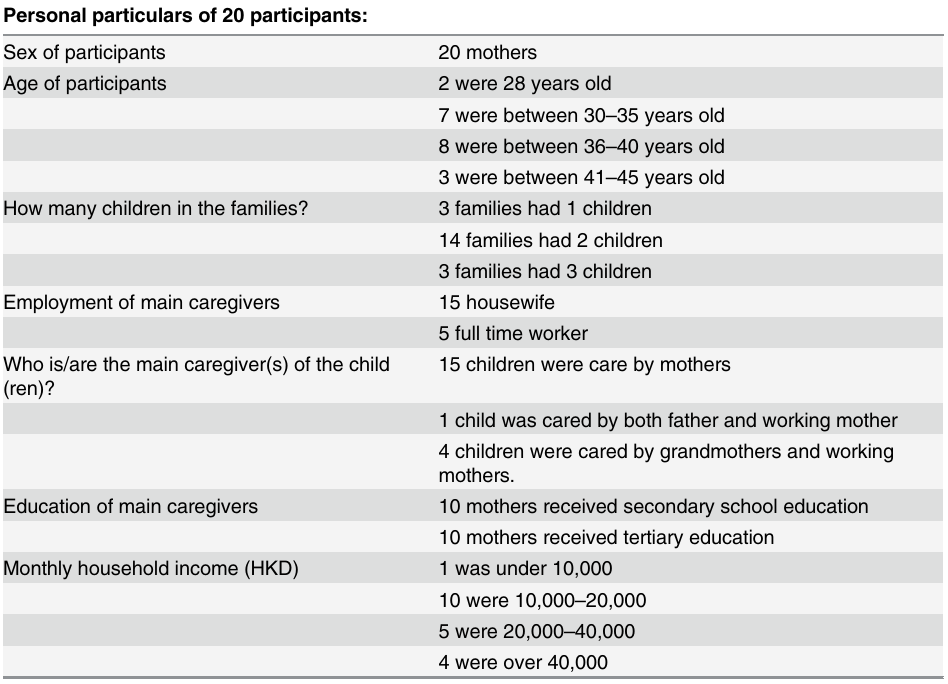
Table 1. Demographic data of 20